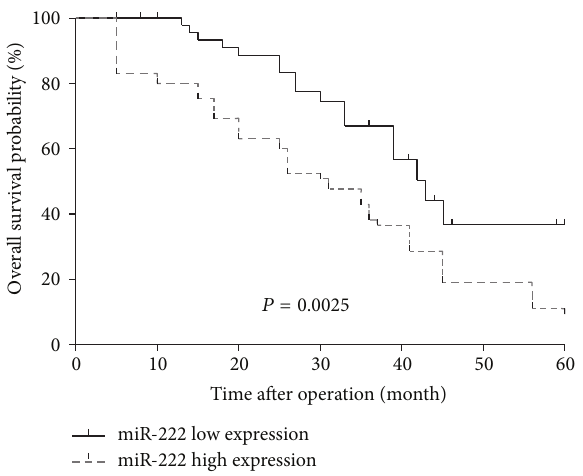
Figure 2: The Kaplan-Meier survival curve in relation to miR-222 expression level in 100 patients with NSCLC. The survival rate of patients with high miR-222 level was significantly lower than that of patients with low miR-222 level (log-rank test 𝑃 = 0.0025 ).